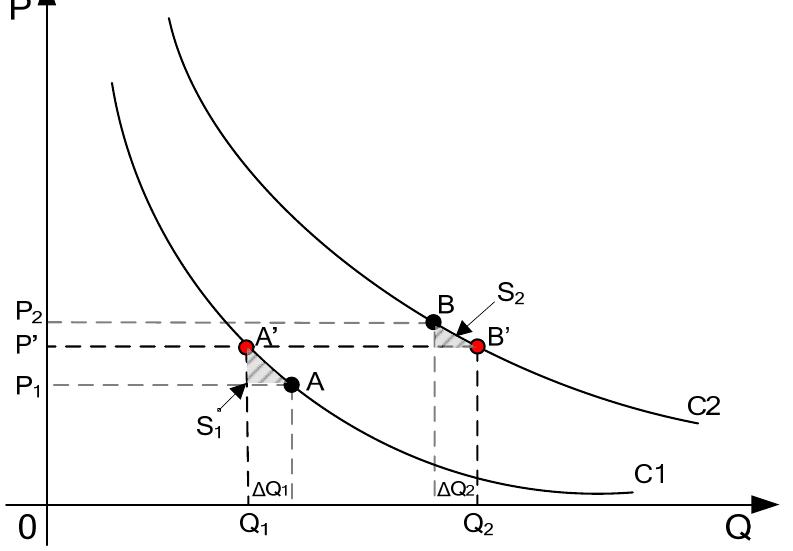
Figure 2. Optimal allocation mechanism of carbon emission rights in the whole society.